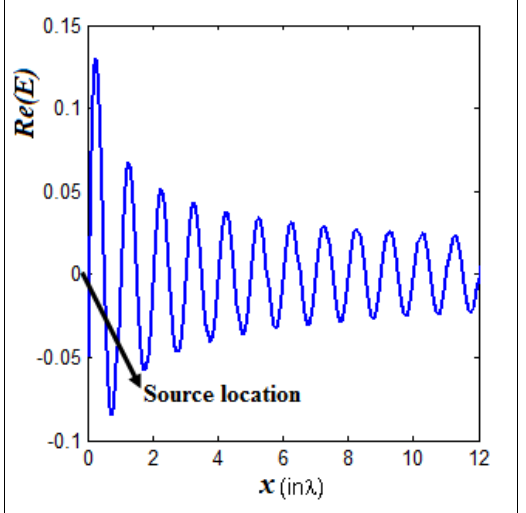
Figure 2. Real part of the electric field generated by a point-source. (x-axis is in terms of wavelength λ